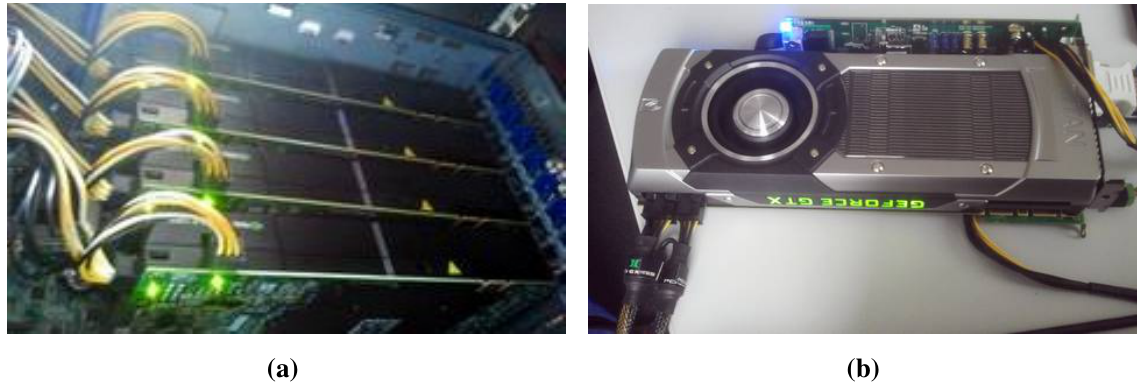
Figure 4. Two complementary ELBE hardware concepts. ( a ) Multi-GPU compute server; ( b ) expansion